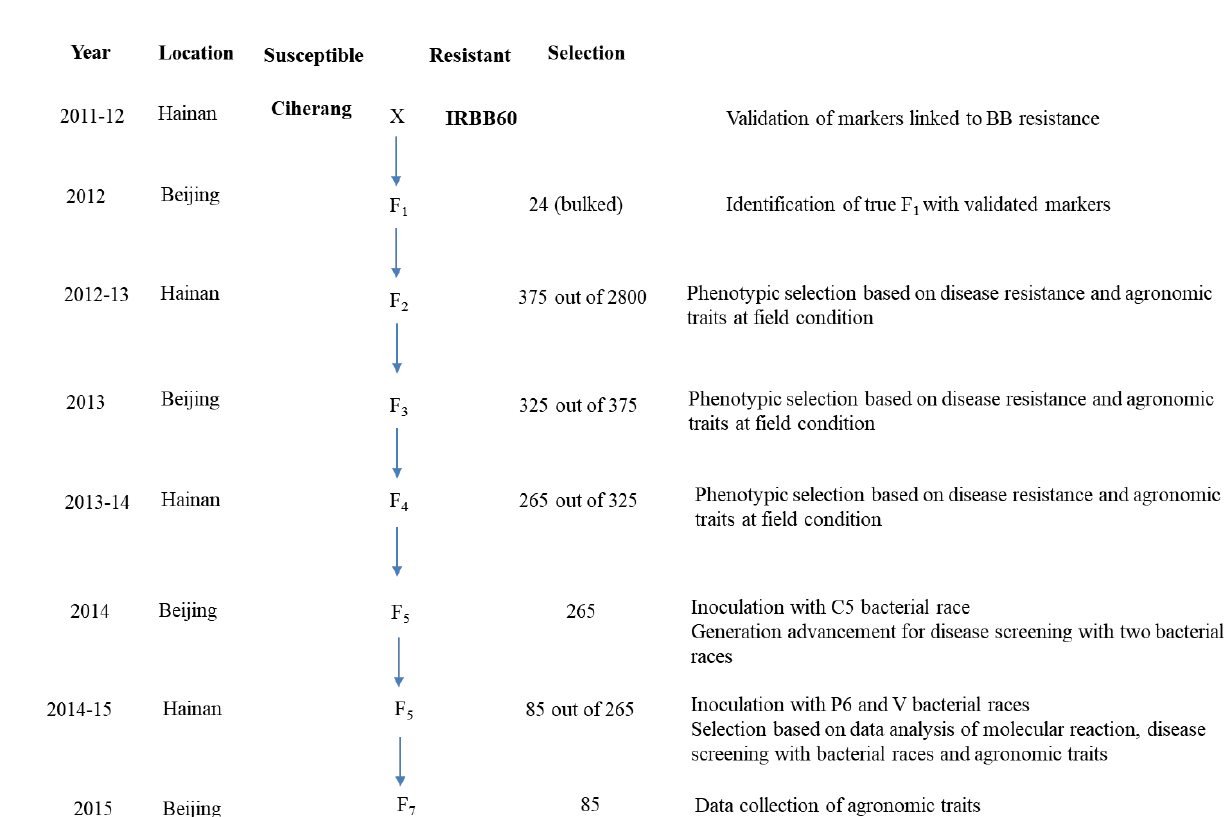
Figure 7. Morphological features of the recipient (Ciherang), donor (IRBB60) parents and their re- combinant lines (RILs).